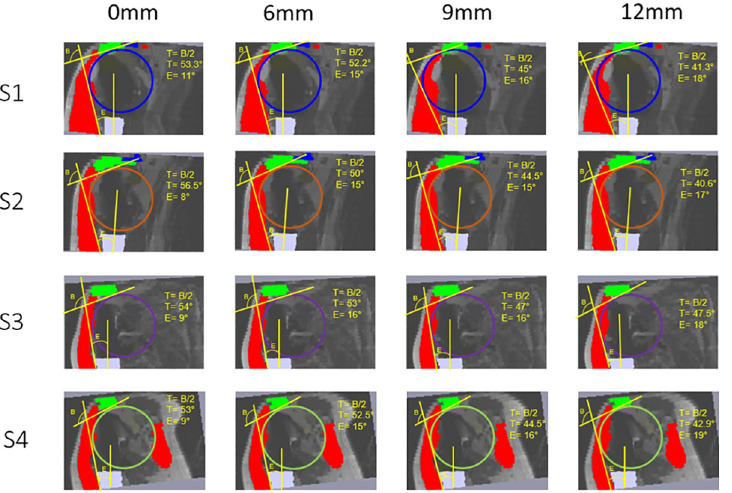
Fig 7. Example of images extracted from SliceOmatic ™ representing the different slices at each lateralization with angle measurements for Patient 1. S1 = Slice 1; S2 = Slice 2; S3 = Slice 3; S4 = Slice 4; Blue Circle = 2D ILSS for Slice 1; Orange Circle = 2D ILSS for Slice 2; Purple Circle = 2D ILSS for Slice 3; Green Circle = 2D ILSS for Slice 4. In red: deltoid muscle; in green = acromion; in blue = clavicle; in white = humeral diaphysis. B = Angle B in degree; E = Angle E in degree; T = B/2. https://doi.org/10.1371/journal.pone.0255817.g007 when comparing lateralization results 2x2 (significance level was p > 0.05 for 6vs9, 6vs12, 9vs12). For DMA, there are no significant difference (significance level was p > 0.05) when comparing initial position (0mm) versus 6mm, 9mm and 12mm; except for S1 and S2 when comparing 0mm versus 9mm and 12mm. (significance level was between p = 0.04 � and p = 0.001 � ).